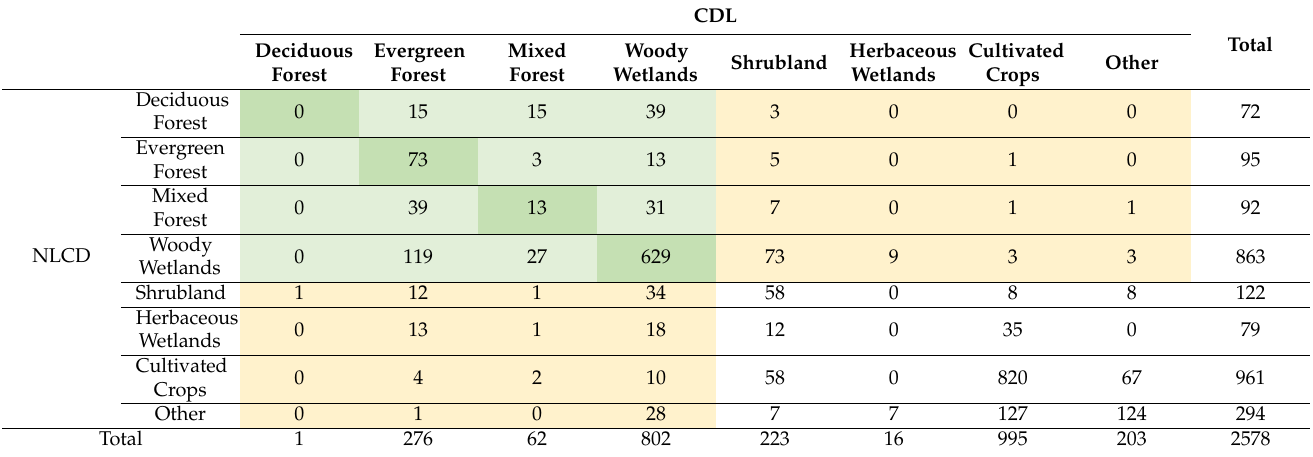
Table 2. Study area: NLCD and CDL comparison; pixel count in alternative land